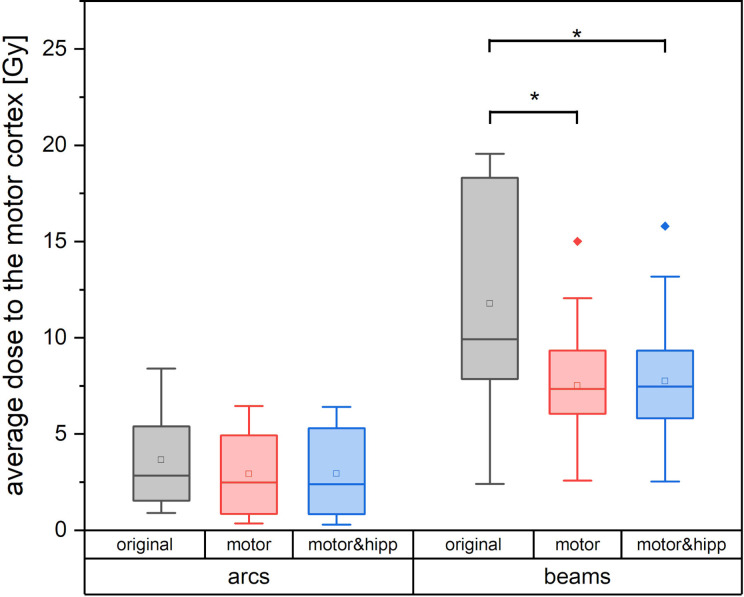
Average dose to the motor cortex for plans using non-coplanar conformal arcs vs. plans with static beams or intensity-modulated radiotherapy (IMRT). Statistically significant differences are denoted by asterisk.